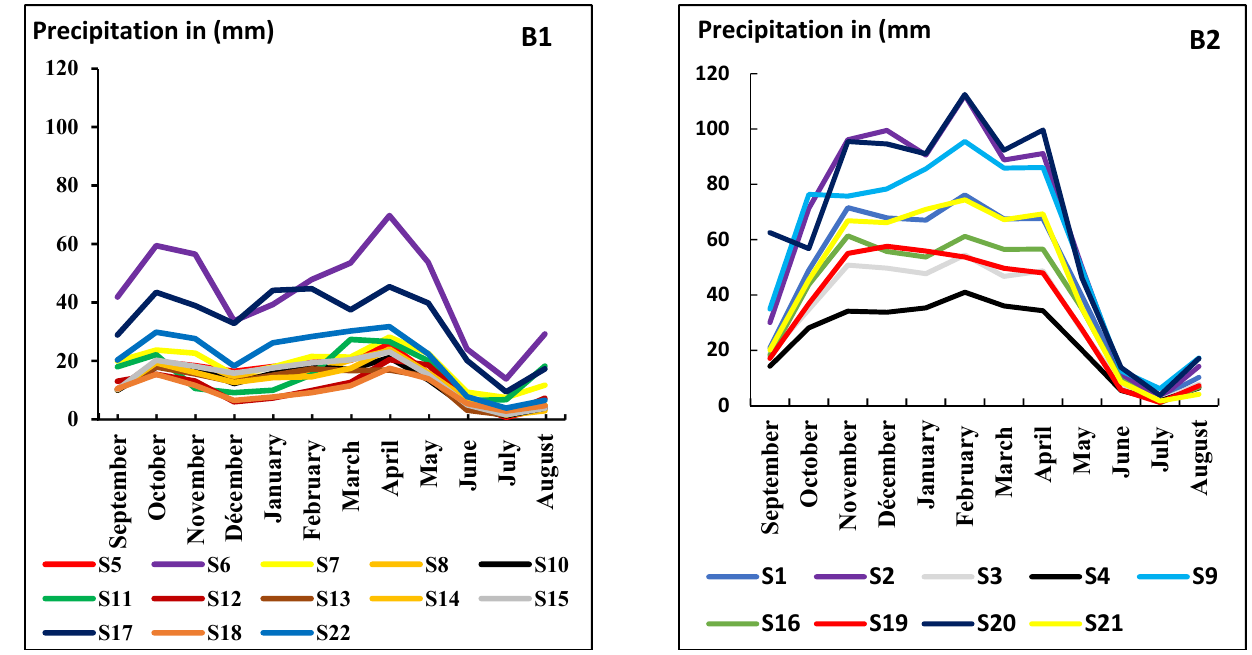
Figure 5. Monthly rainfall regime of the two clusters ( B1 , B2 ) after homogenization.